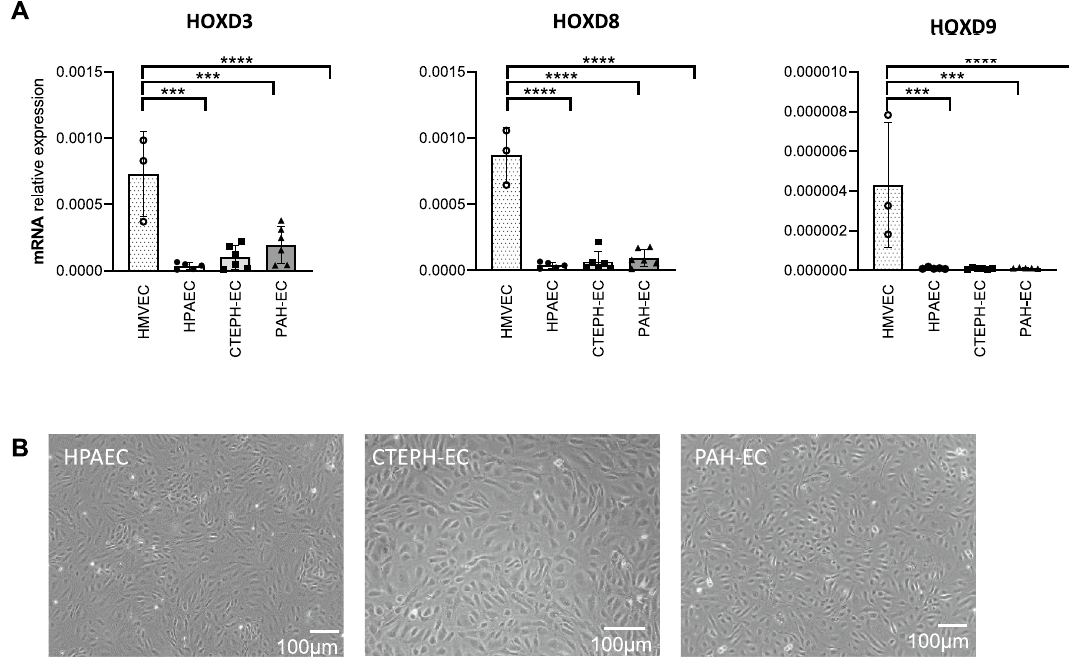
Figure 1. HOXD gene expression. ( A ) mRNA expression levels of HOXD3, HOXD8 and HOXD9 were found significantly higher in HMVEC-L compared to HPAEC, CTEPH-EC and PAH-EC. No differences in gene expression were found between HPAEC, CTEPH-EC and PAH-EC. HMVEC-L, n = 3; HPAEC, n = 5; CTEPH-EC, n = 6; PAH-EC, n = 3; One-way ANOVA, p < 0.001 = ***; p < 0.0001 = ****, data is expressed as mean ± SD. Statistical analysis was performed with GraphPad Prism 7 software, version 7.0e, serial number:GP7- 0633739-R###-#####,https:// www. graph pad. com. ( B ) Representative pictures of cultured HPAEC, CTEPH-EC and PAH-EC, × 10